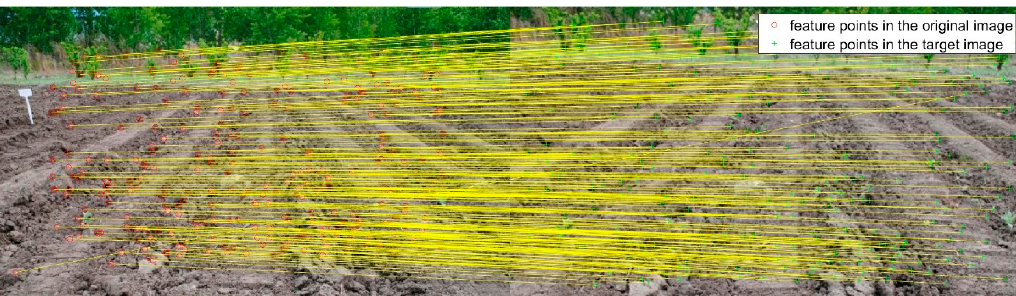
Figure 3. The registration result of FAST − M for target image in Figure 2b.